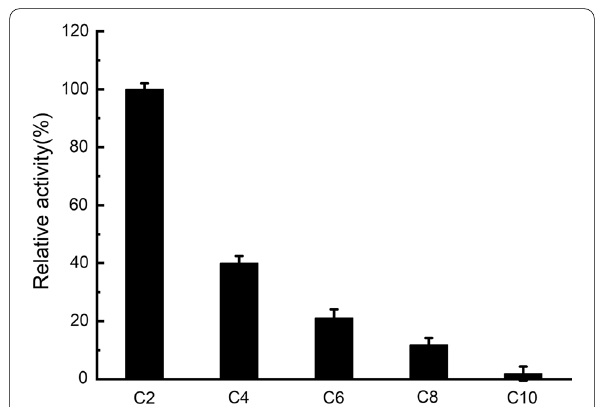
Fig. 2 Substrate specificity of esterase Tan410 toward p -nitrophenyl esters Fig. 3 Effect of pH on activity of esterase